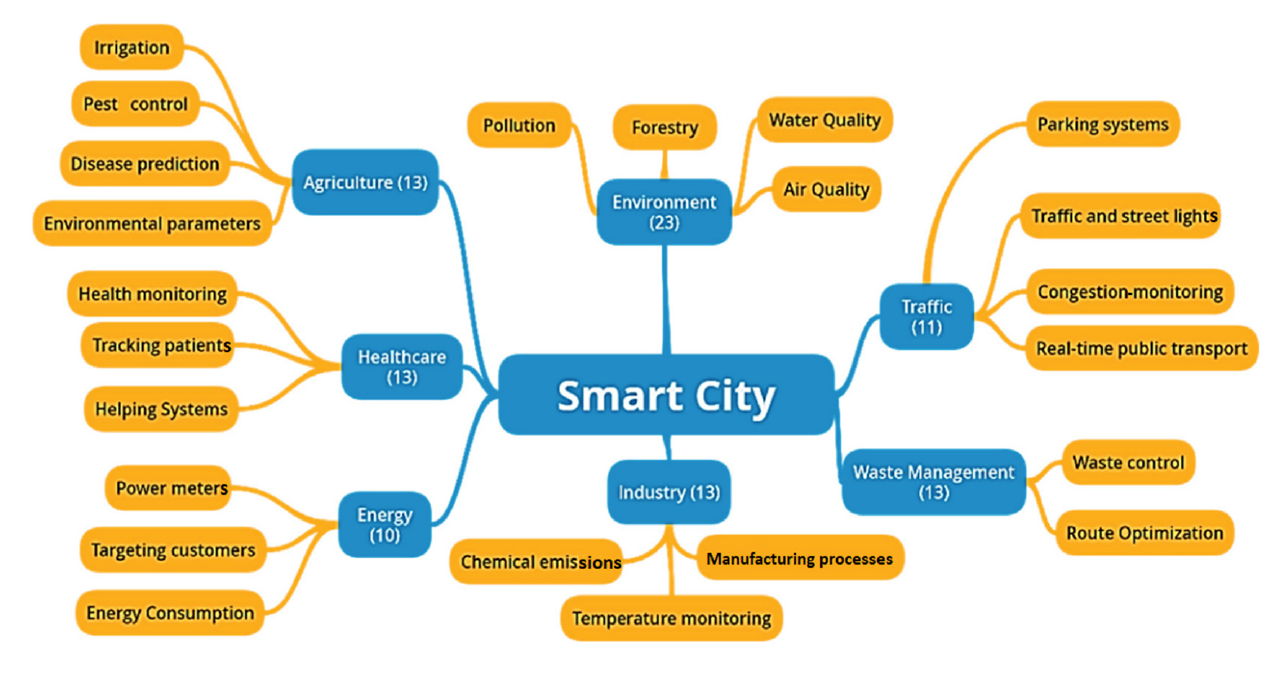
Figure 3. Application of LoRaWAN.